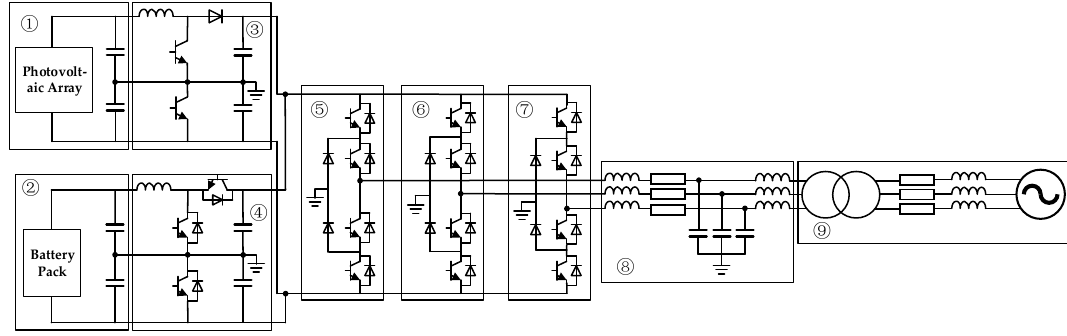
Figure 14. The photovoltaic-battery hybrid generation system with partitioning into nine subnetworks.